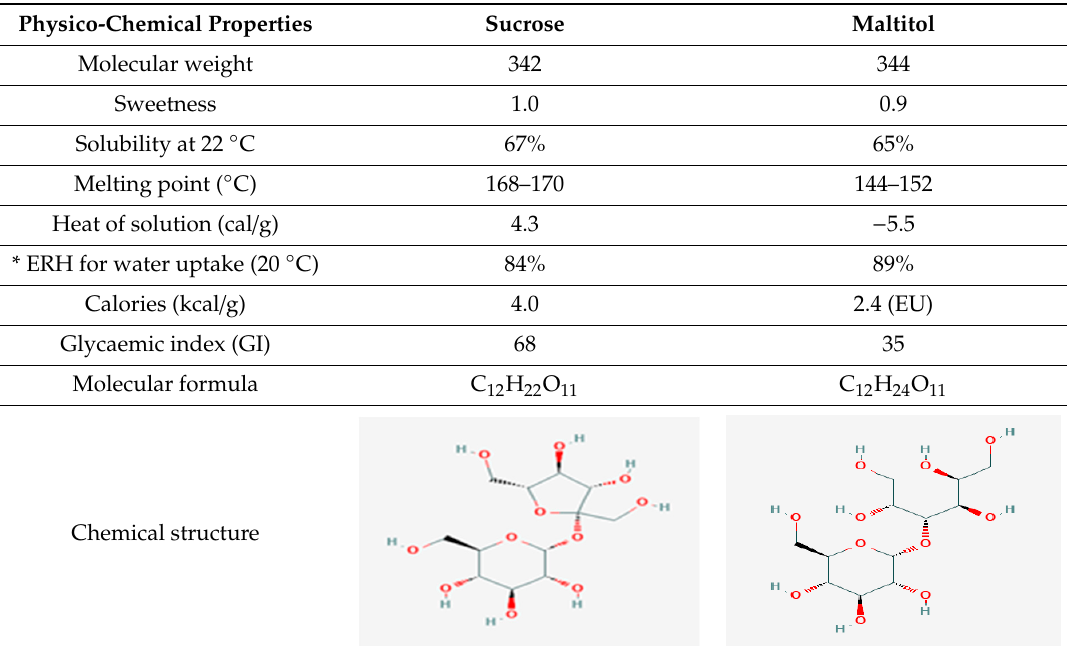
Table 2. A comparison of some physico-chemical properties for sucrose and maltitol. Physico-Chemical Properties Maltitol